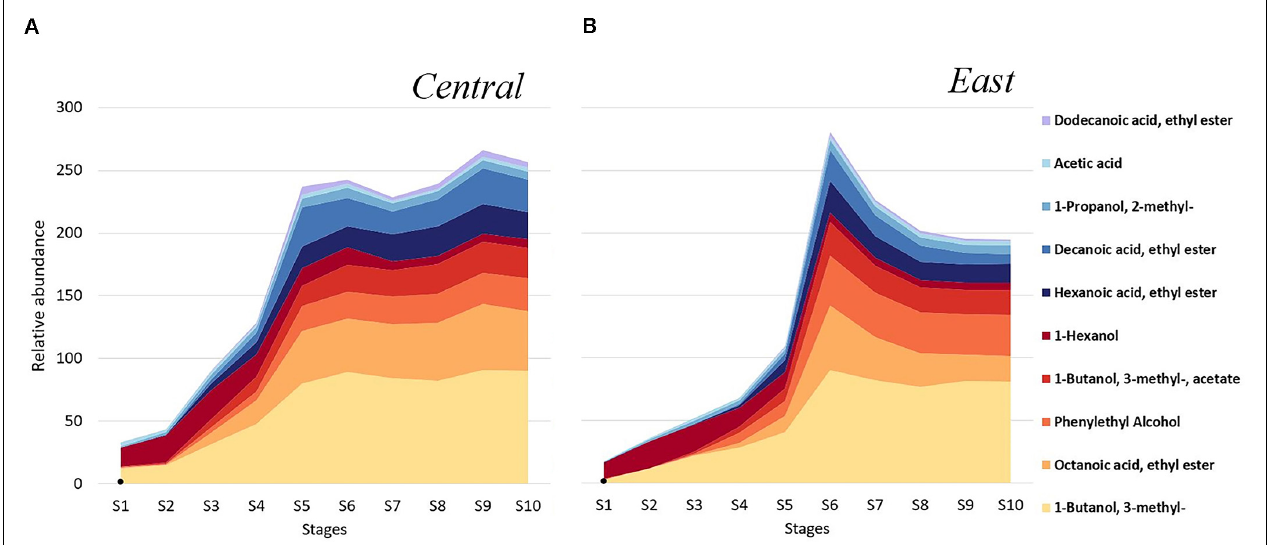
FIGURE 5 | Chambourcin volatile metabolites distribution in wines from the Central ( n = 5) and East ( n = 4) regions. Shown are the top 10 most abundant volatile compounds in the samples throughout fermentation from the (A) Central, and the (B) East region. Relative abundance of each volatile metabolite was obtained from calculating metabolite peak area divided by IS peak areas which was acquired from each sample throughout each fermentation